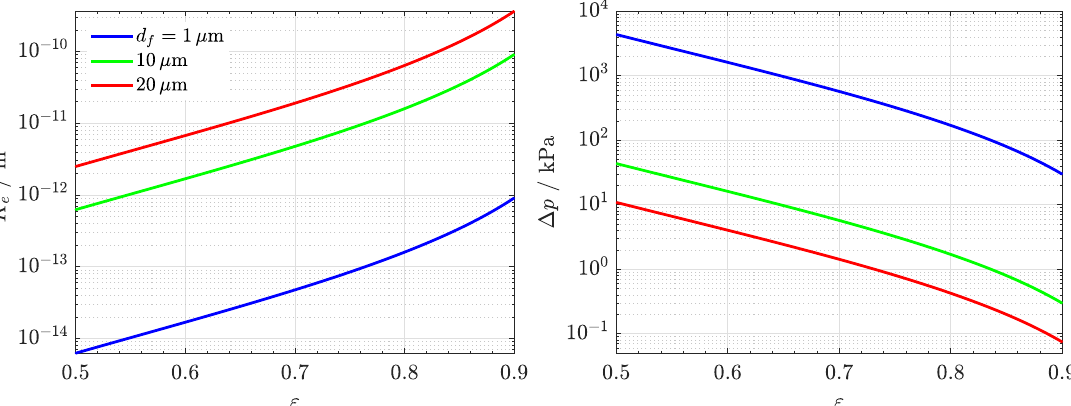
Figure 9. Variation of ( left ) the permeability of the electrode, K e , and ( right ) the overall pressure drop, ∆ p , as a function of the porosity of the electrode, ε , for various fiber diameters, d estimated according to the Carman–Kozeny equation (Equation